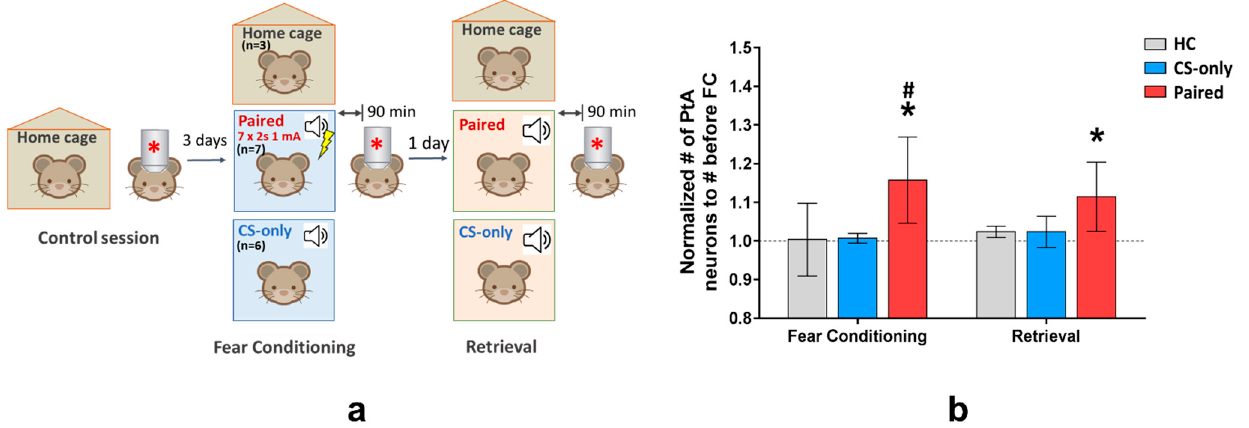
Figure 3. ( a ) Design and timeline of the in vivo imaging experiment with Fos-EGFP mice. ( b ) Number of PtA Fos-EGFP positive neurons normalized to the number of neurons active during the control session (mean, 95% CI). The number of Fos-EGFP positive neurons was increased during learning and memory retrieval on the next day in the Paired group ( n = 7) but not in the control groups (* p = 0.0156, compared with 1, t -test; # p < 0.05 compared with CS-only ( n = 3) and HC group ( n = 3) groups, two-way ANOVA and post hoc Tukey test).